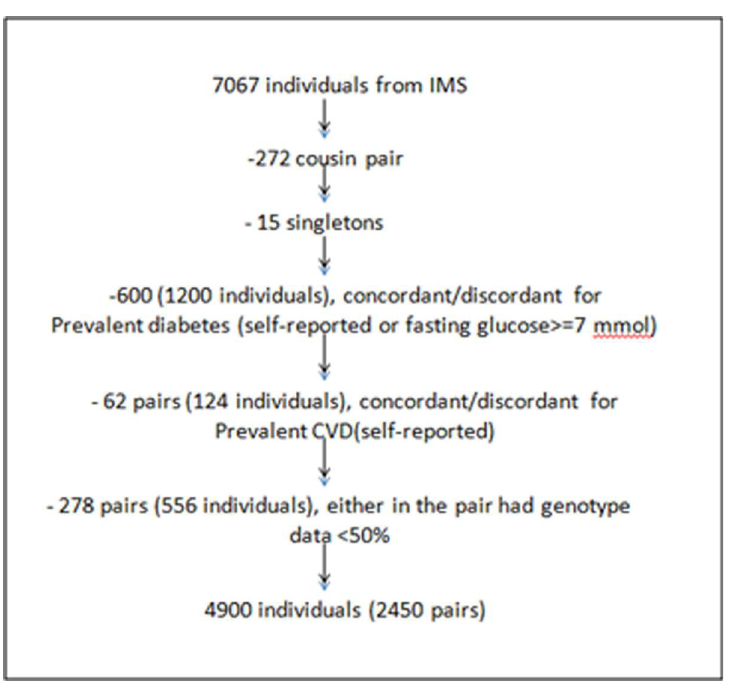
Fig 1. Sampling strategy for present analyses from Indian Migration